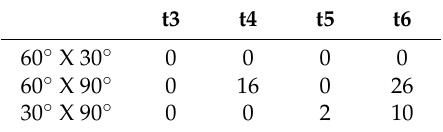
Table 11. Significant difference scores (%) between the three task area sizes (field study). t3